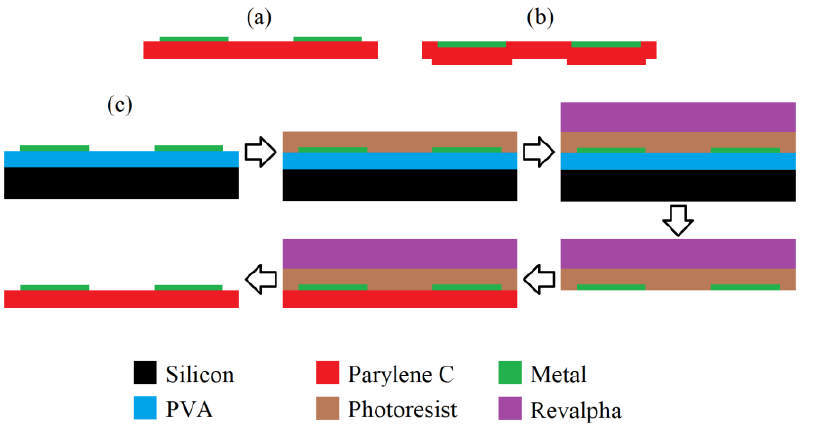
Figure A2. Metallic structures on Parylene obtained by direct metallization ( a ) and the transfer process ( b ). Process for the realization of a transferred metallization that features only one interface with Parylene ( c ).